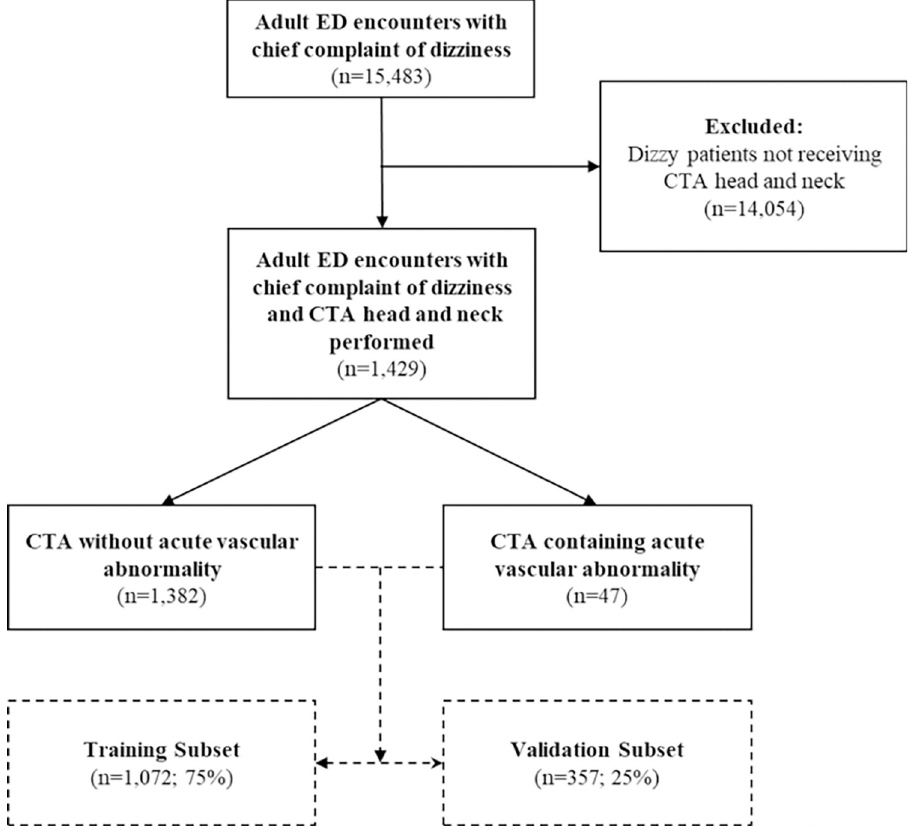
Fig 1. Flow of patients to categorization of acute vascular abnormality on CTA and subsequent temporal separation of cases into a training and validation cohort.